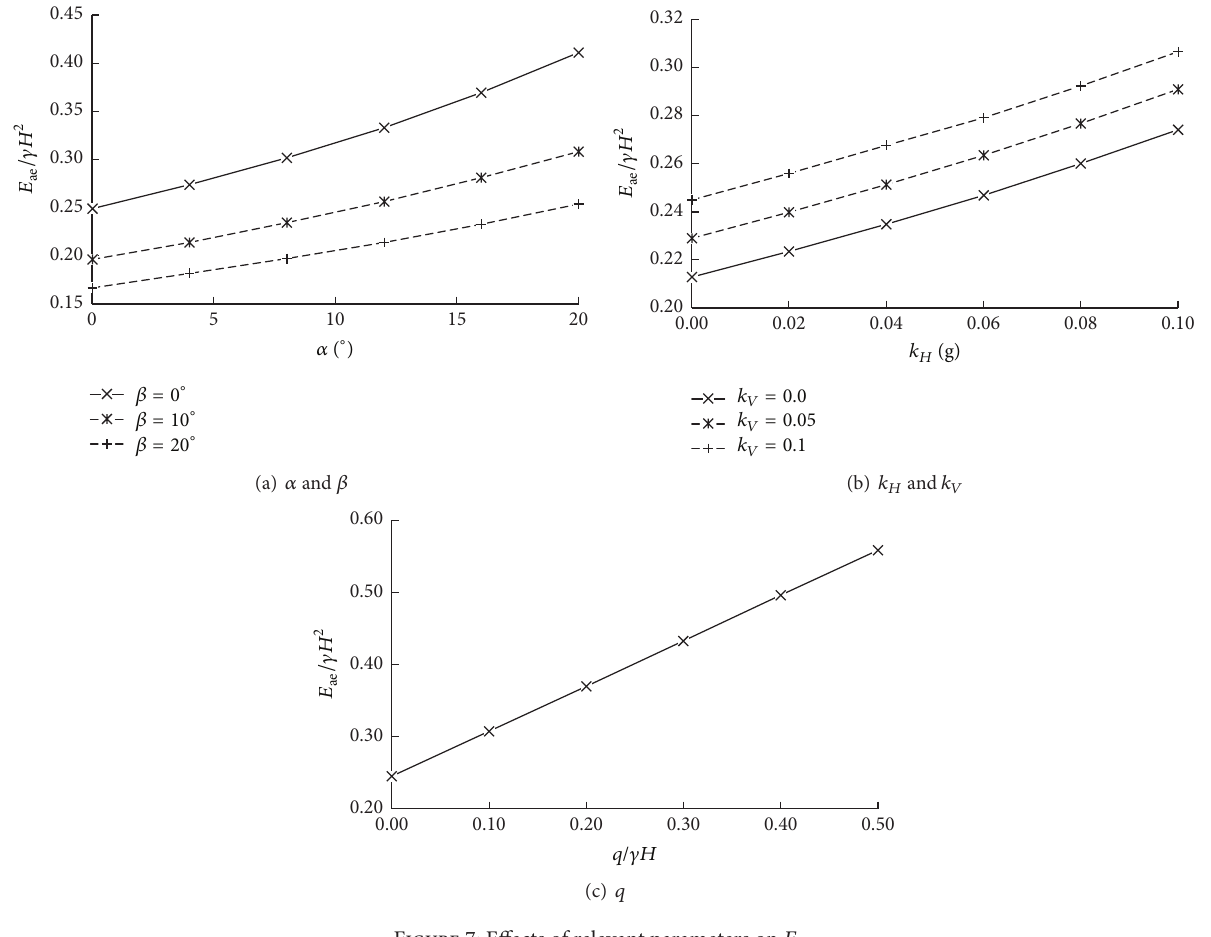
Figure 7: Effects of relevant parameters on 𝐸 ae